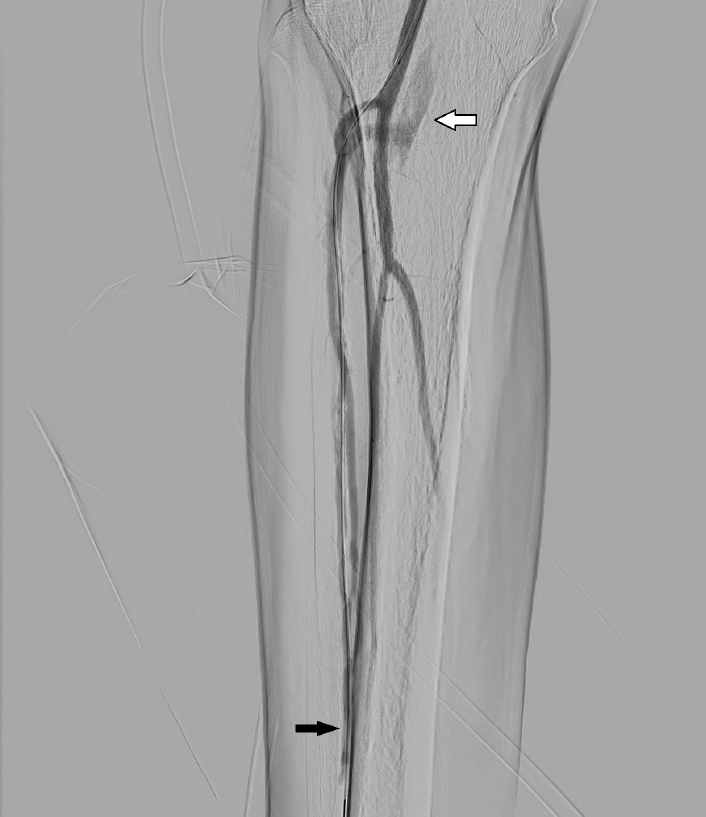
Figure 8. Iatrogenic arteriovenous fistula (black arrow) between anterior tibial artery and anterior tibial vein with early opacification of popliteal vein (white arrow).